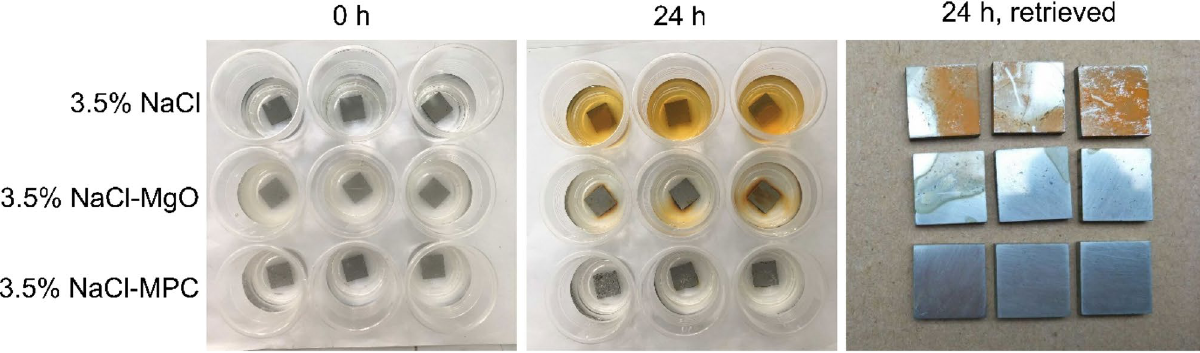
Figure 8. Photographs of uncoated mild steel panels immersed in three liquids for 0 and 24